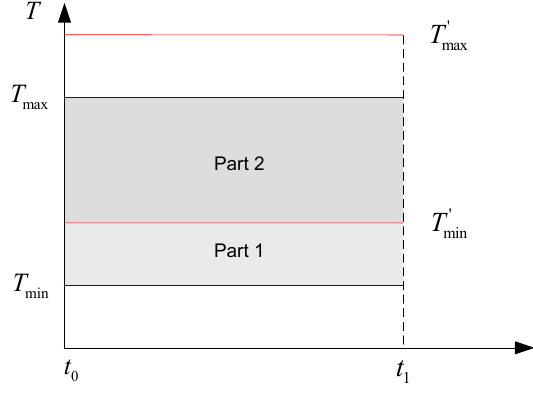
Figure 6. Two-stage regulation in a time step [ t 0 , t 1